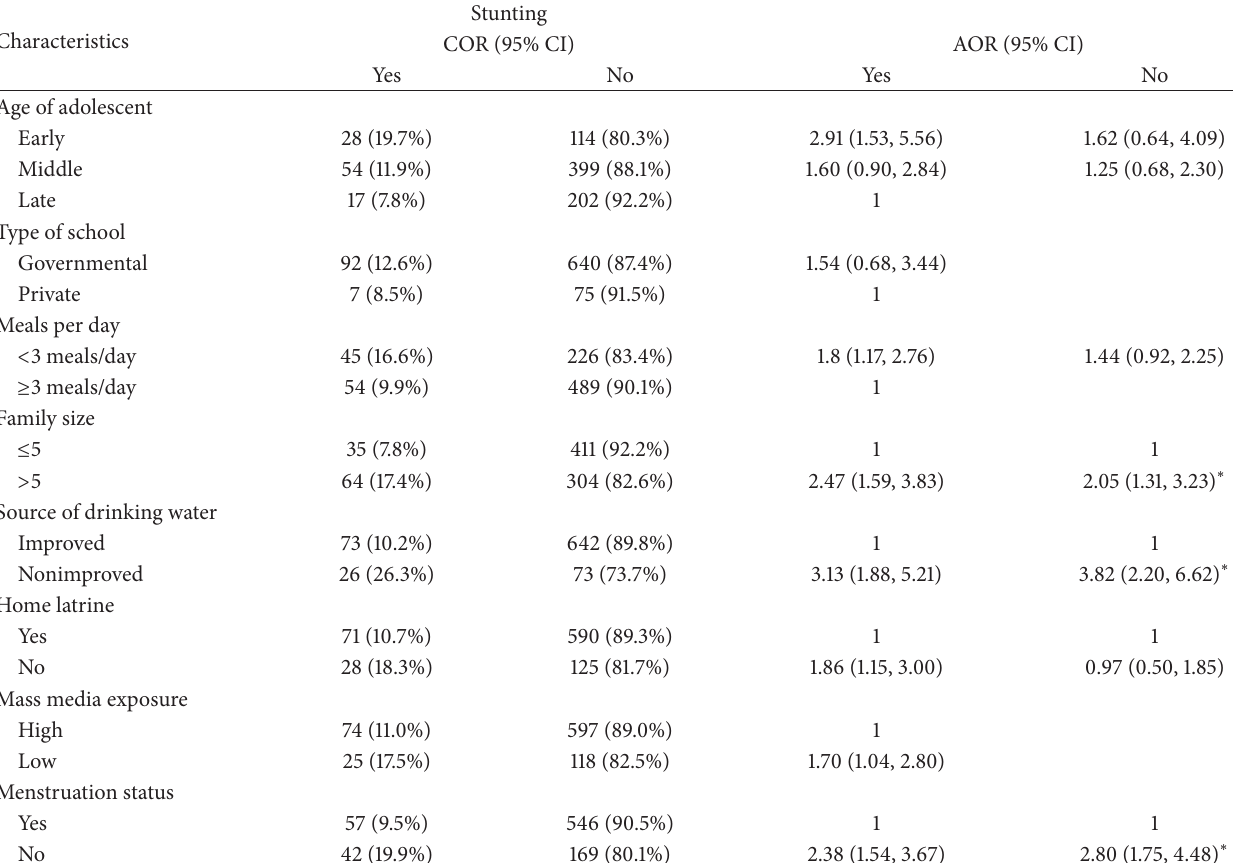
Table 3: Bivariate and multivariate logistic regression of factors associated with stunting among adolescent school girls, Adwa town, Northern Ethiopia,